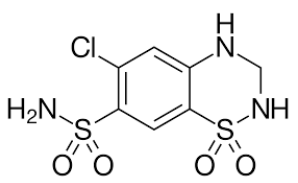
Figure 12. Chemical structure of Furosemide.